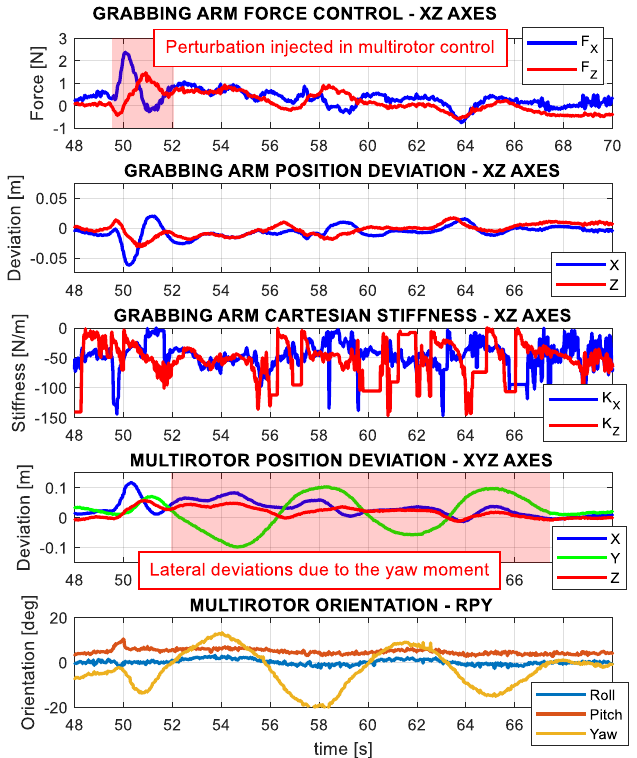
Figure 14. Evolution of the grabbing arm and the multirotor, disturbed at t = 49.6 seconds, during the grabbing maneuver (phase 6) with impedance control in the x - and z -axes ( 𝐾 𝑥 = 𝐾 𝑧 = 50⁡𝑁/𝑚 ).